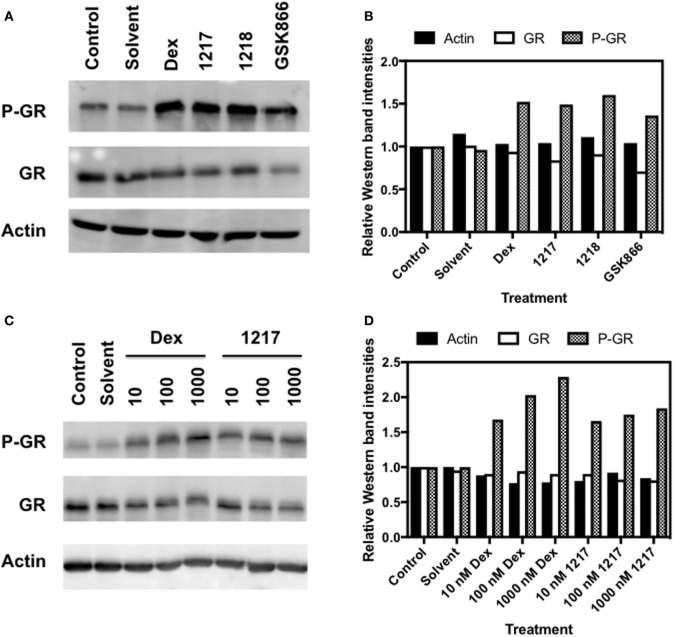
Selective glucocorticoid receptor agonist GSK866 and its analogs UAMC-1217, UAMC-1218 trigger glucocorticoid receptor (GR) Ser211 phosphorylation. (A) Western detection of expression levels of Actin, GR, and GR Ser S211 phosphorylation in HaCat cells following 6 h treatment with 1 µM Dex, UAMC-1217, UAMC-1218, or GSK866. (B) Bar plot representation of Western blot intensities of Actin, GR, and GR Ser S211 phosphorylation observed in panel A, as quantified by Image J. (C) Western detection of expression levels of Actin, GR expression, and Ser S211 phosphorylation in HaCat cells following 6 h treatment with, respectively, 10, 100, or 1,000 nM Dex or UAMC-1217. (D) Bar plot representation of Western blot intensities of Actin, GR, and GR Ser S211 phosphorylation observed in panel (C), as quantified by free Image J software.